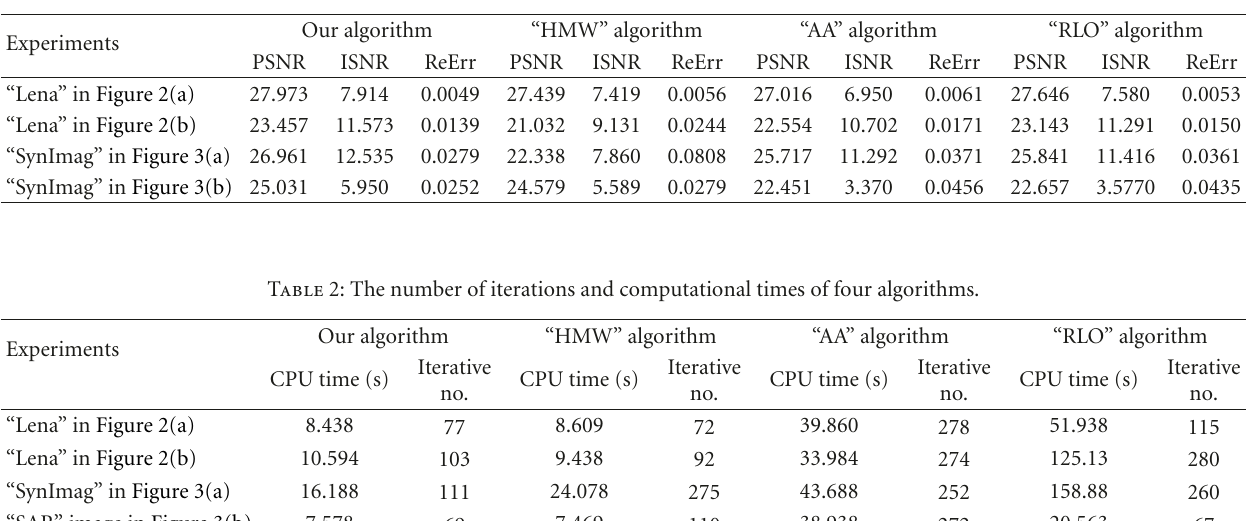
Table 1: The PSNR, ISNR, and ReErr of the restored images using four methods. Experiments